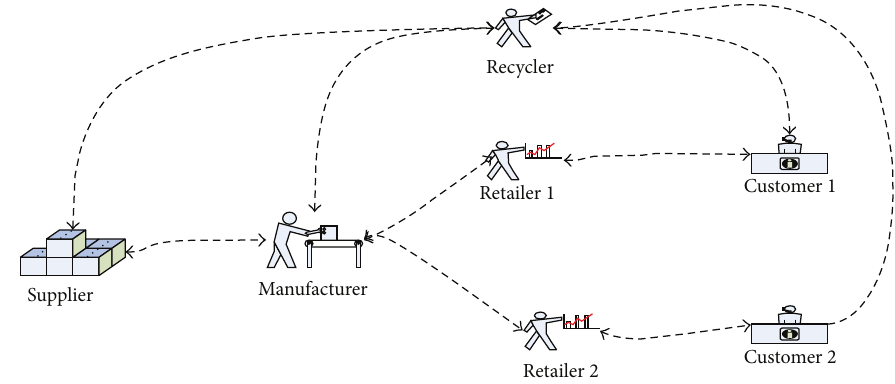
Figure 1: Supply chain distribution system conceptual model.